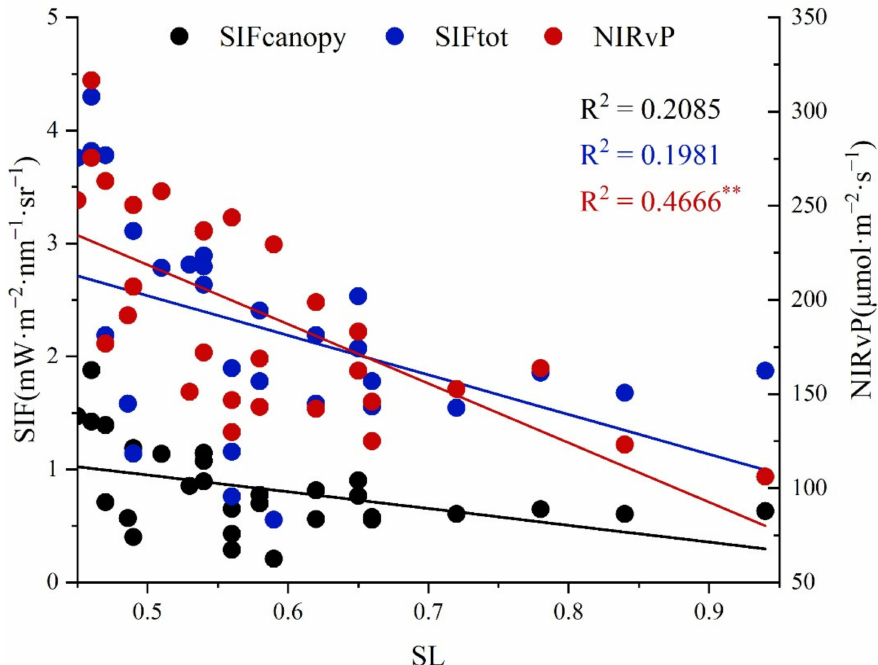
Figure 7. Overview of the relationships between the severity level (SL) and SIF canopy -related variables at a severe stage of disease onset ( n = 29). Where ** indicates extremely significance at p < 0.001 level.